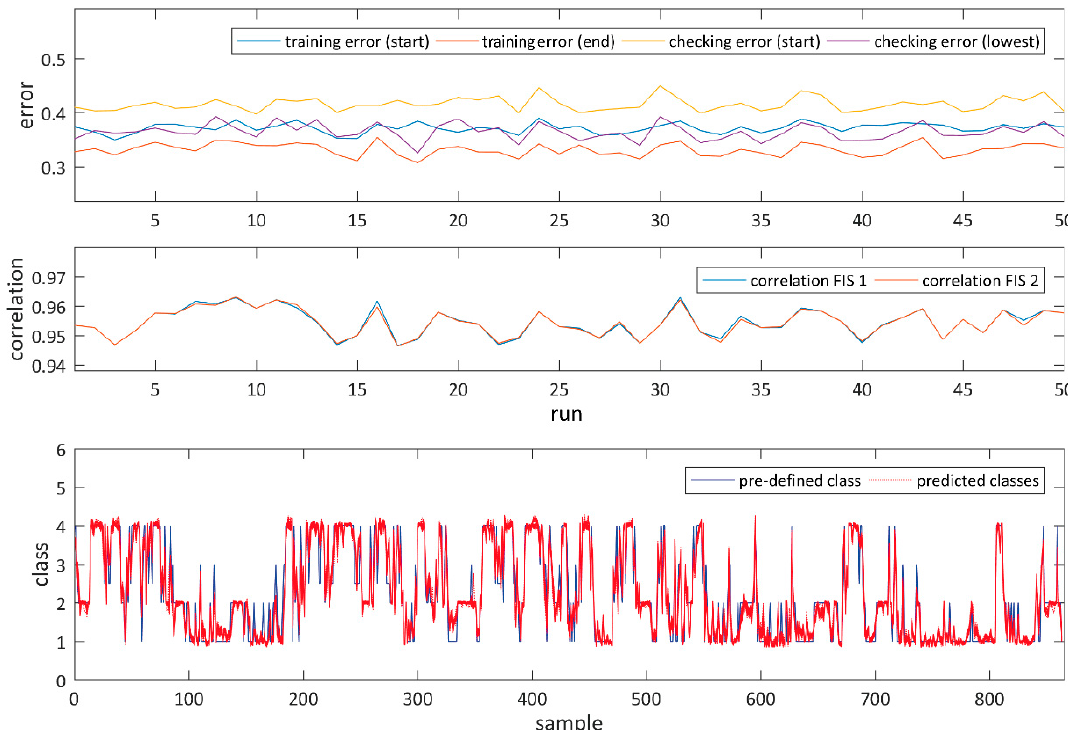
Figure 9. Results and parameters of the fuzzy inference system build from iron and natural gamma log input data. Training and checking error are low, as in the case of predicting from Fe% and Al 2 O 3 %; correlation between predicted and pre-defined classes is high as well (>94%) showing that a substitution of the natural gamma log for the aluminum assay is feasible for predicting iron ore lithologies.